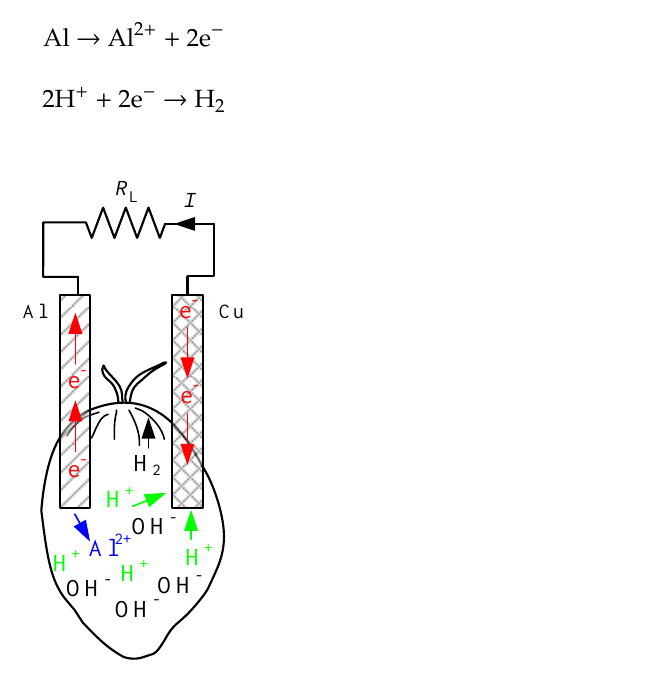
Figure 2 . Schematic diagram of oil palm fruit battery electrochemical cell. Figure 2. Schematic diagram of oil palm fruit battery electrochemical